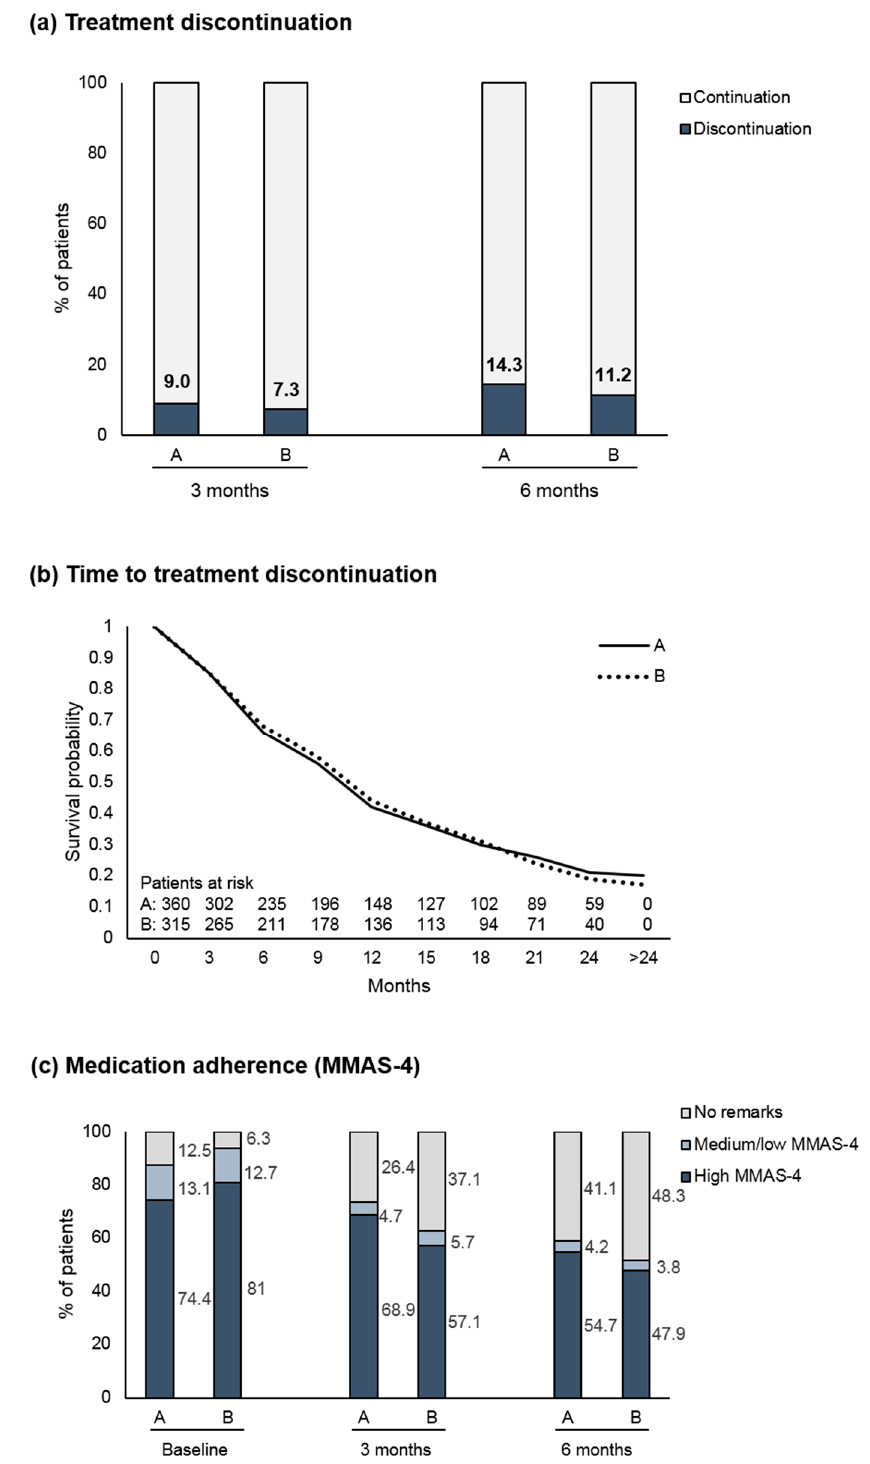
Figure 1. ( a ) Rates of treatment discontinuation after 3 and 6 months. Displayed are the discontinuations for reasons other than disease progression, death, or start of new cancer therapy, ( b ) Time to treatment discontinuation (Kaplan–Meier analysis), ( c ) Morisky Medication Adherence Scale (MMAS-4); Arm A: adherence-enhancing measures comprising educational / counseling measures as well as reminder elements, Arm B: no adherence-enhancing measures.